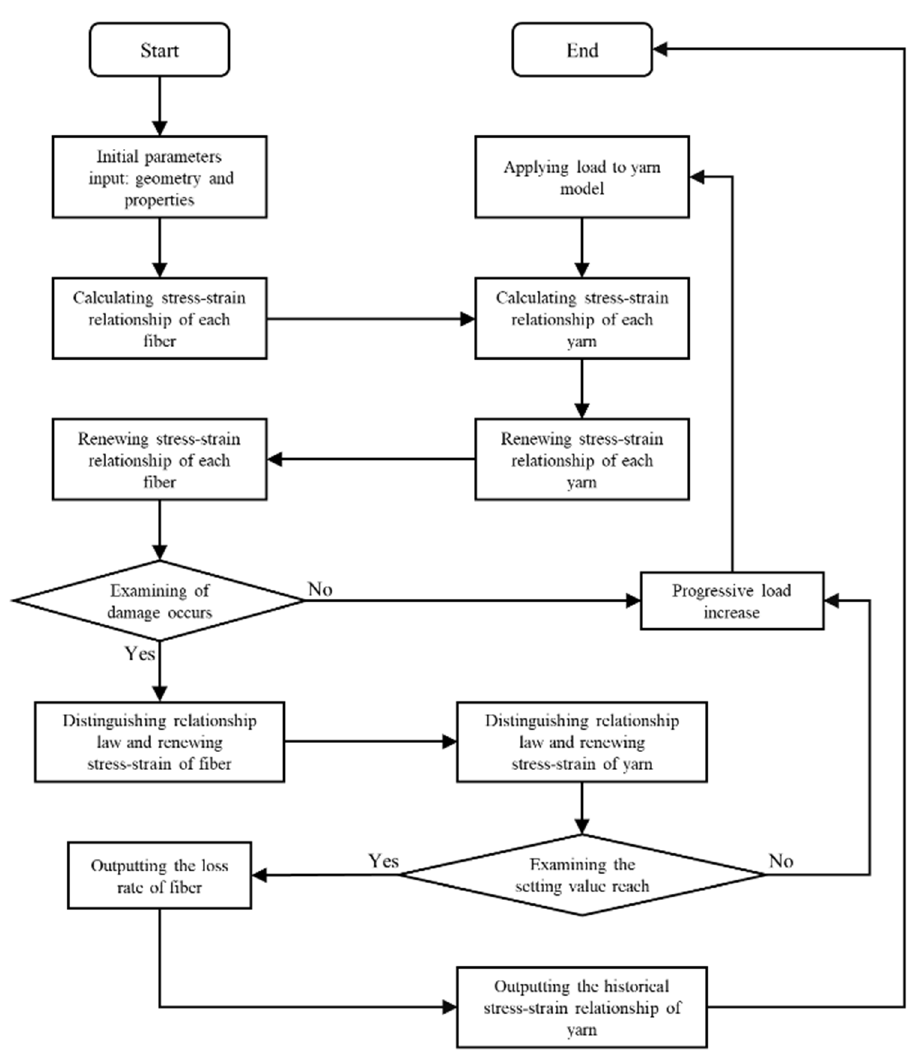
Figure 4. Flow chart for mechanical properties prediction of